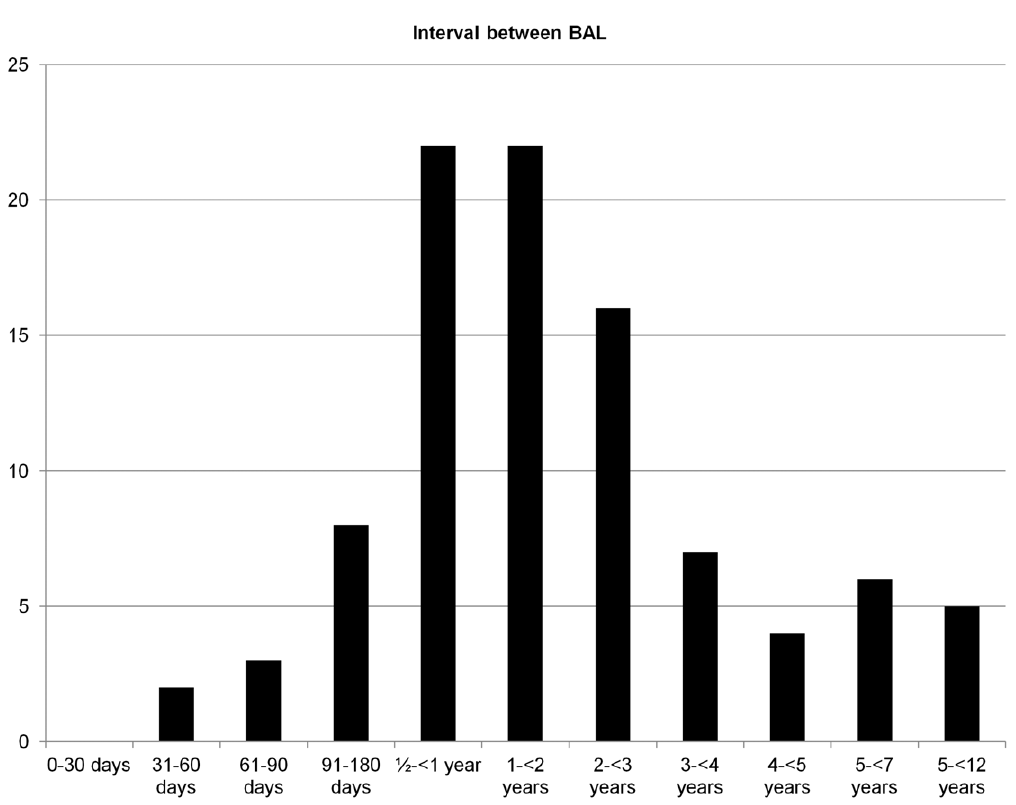
Figure 2. Interval between bronchoalveolar lavages in healthy never-smoking subjects undergoing more than one investigation (number of investigations on y-axis). doi:10.1371/journal.pone.0043644.g002 PLOS ONE |